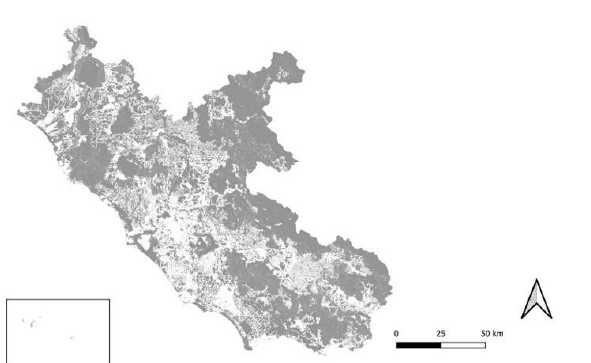
Figure 1 . Compatible landscapes with limitations for large- scale photovoltaic installations (in exerpt Latium